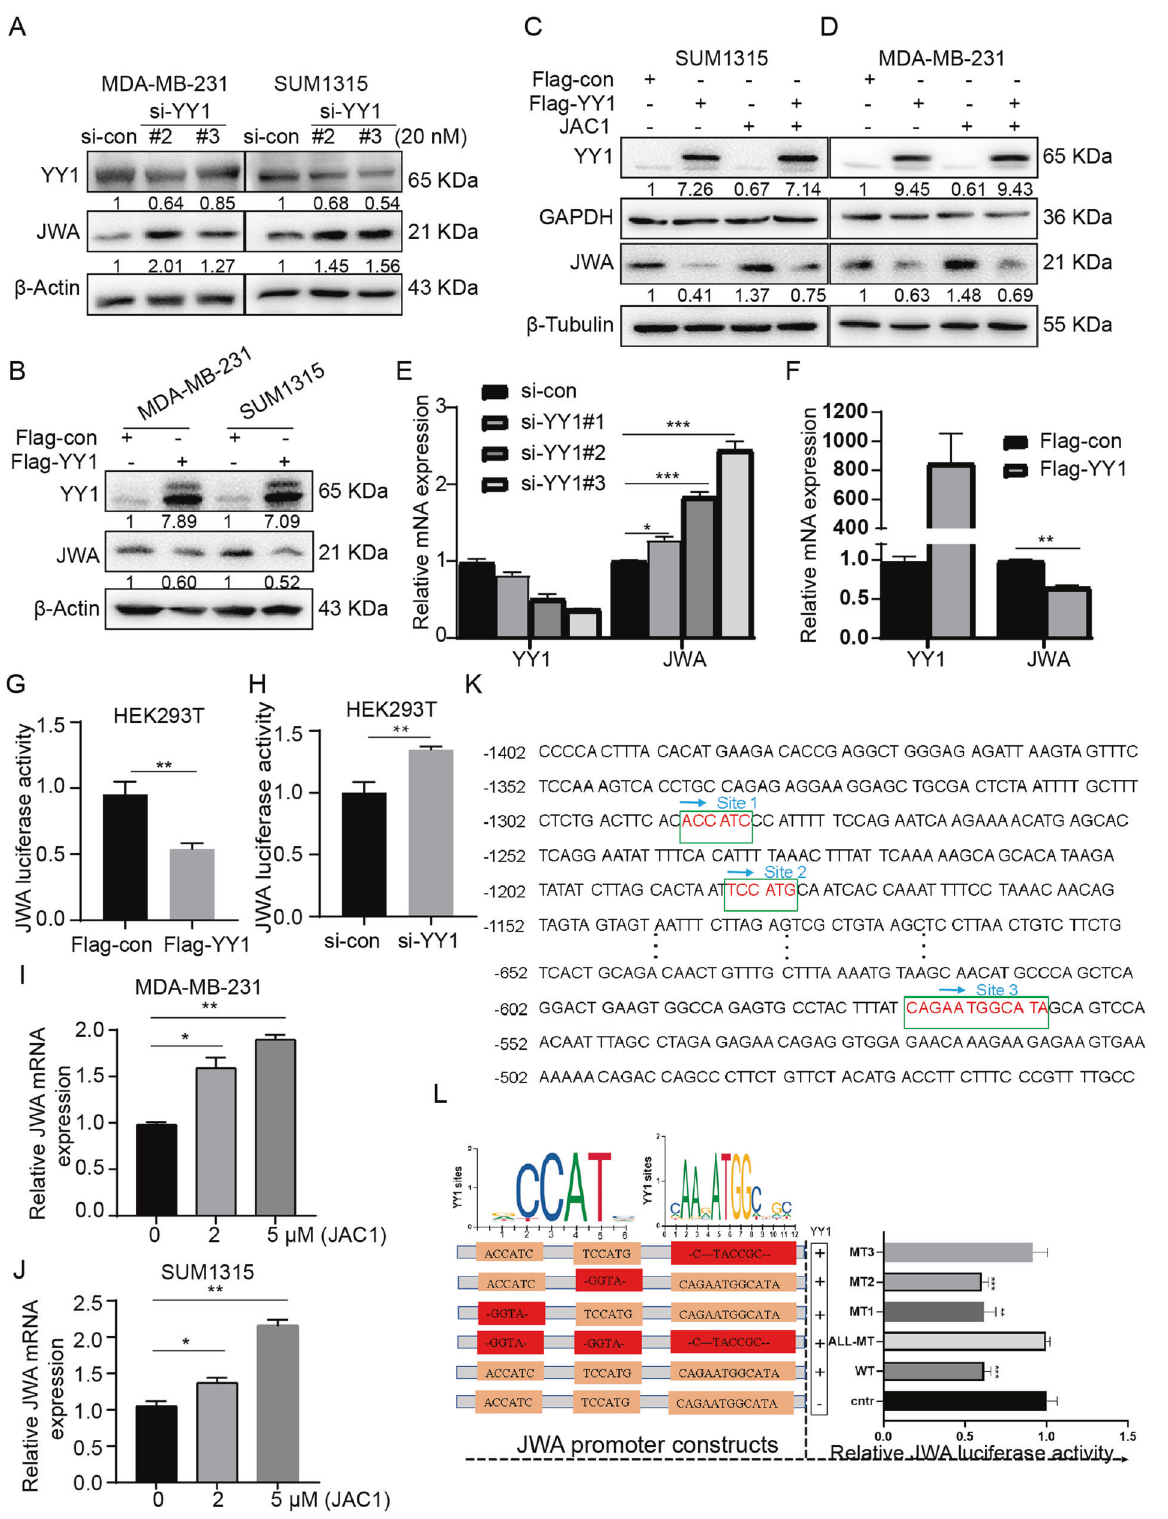
Fig. 6 JAC1 targets YY1 and removes the transcriptional inhibition of YY1 on JWA in TNBC cells. The relative expressions of JWA were detected by Western blot after transfected with si-YY1( A ) or Flag-YY1( B ) in MDA-MB-231 and SUM1315 cells. JWA expressions were analyzed by Western blot in SUM1315 ( C ) and MDA-MB-231( D ) cells after treated with JAC1 or Flag-YY1 or co-treated. The JWA mRNA expression was detected by RT-PCR after transfected by si-YY1( E ) or Flag-YY1( F ) for 48 h in MDA-MB-231 cells. JWA promoter luciferase activities were analyzed in HEK293T cells after transfected by si-YY1( G ) or Flag-YY1( H ) plasmid. I , J The relative JWA mRNA expression was detected by RT- PCR after treated with indicated doses of JAC1 in MDA-MB-231( I ) and SUM1315 ( J ) cells. K Three putative YY1 binding sites in the JWA promoter regions. L JWA promoter Luciferase activities were detected after transfected by luciferase reporter gene plasmid which mutated in putative YY1 binding sites. * P < 0.05; ** P < 0.01; *** P < 0.001. N.S. no signi fi cant differences. Cell Death Discovery (2022)